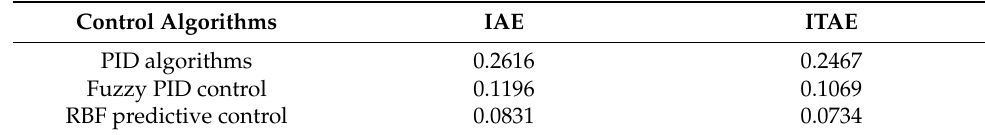
Table 2. Comparison of performance indicators of different